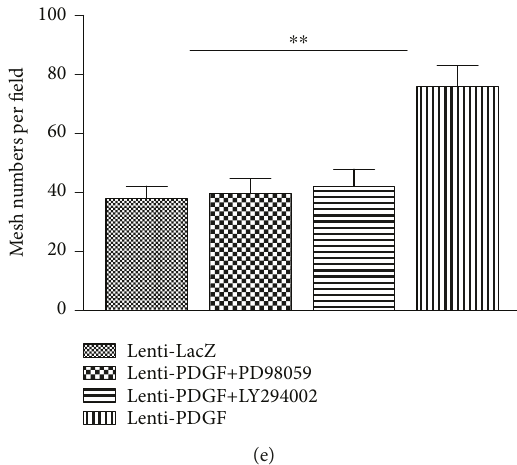
Figure 4: PDGF-BB secreted by Lenti-PDGF-B-modi fi ed BMSCs enhanced HUVEC migration and angiogenesis via the PI3K/AKT and ERK1/2 signaling pathways. (a) HUVECs on chemotaxis membranes stained with hematoxylin. (b) Cell numbers in each fi eld. (c) PDGF-BB secreted by PDGF-B-modi fi ed-BMSCs induced ERK and AKT activation in HUVECs. (d) Optical images of HUVECs cultured on Matrigel with di ff erent supernatants after 12h (upper panel); in the lower panel, ImageJ was used to measure the mesh number formed by HUVECs (green circle indicated mesh structure formed by HUVECs). (e) The mesh numbers in each group. ∗∗ P < 0 01 ; scale bar: 100 μ m. HUVECs: human umbilical vein endothelial